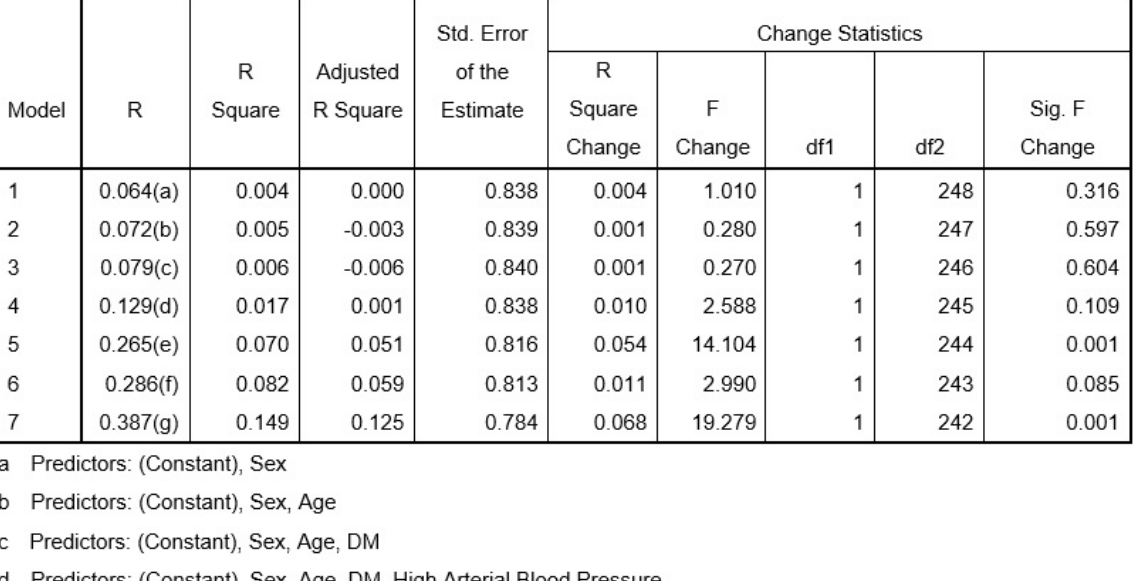
6 of 13 Table 8. Evolution of SARS-CoV-2 patients treated with Tocilizumab. COVID-19 Patients